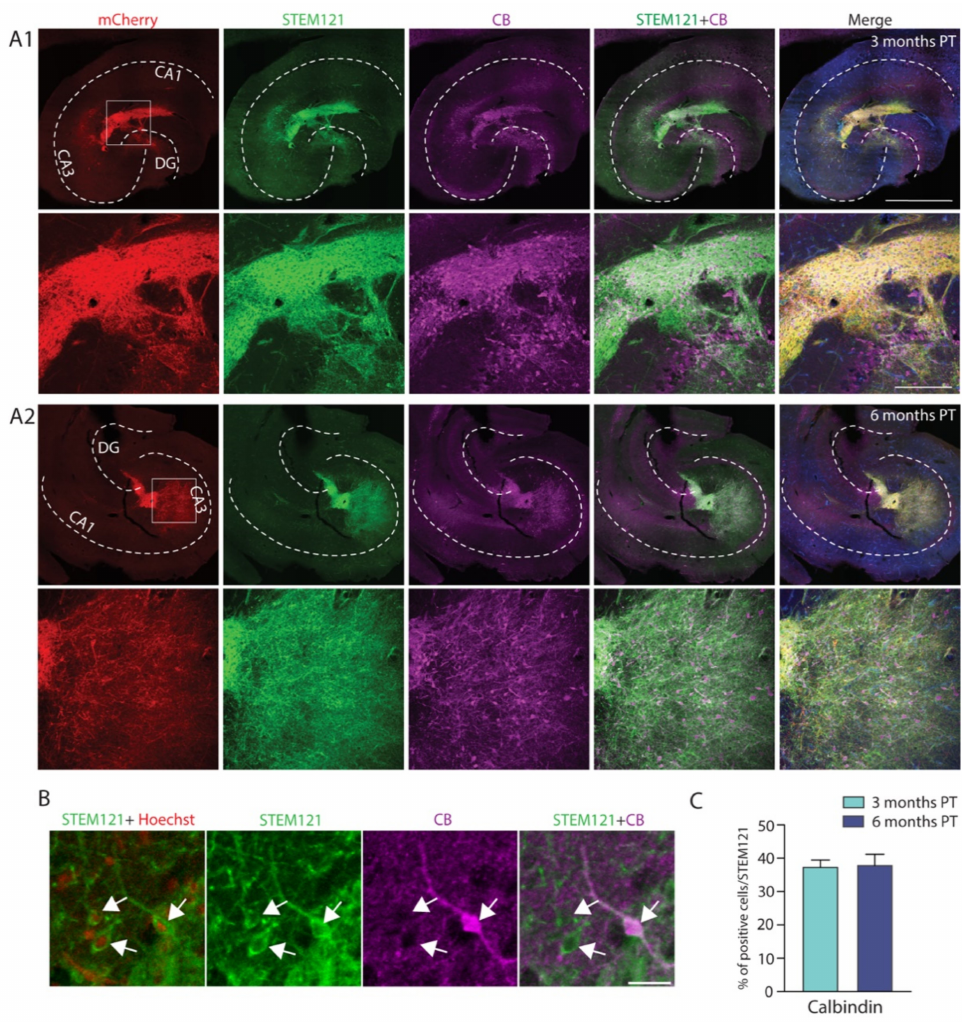
Figure 7. Grafted hdInts express calbindin, a marker of a GABAergic interneuron subpopulation. ( A ) Immunofluorescent images of hippocampal sections with grafted hdInts stained for mCherry (marker for ChR2; red), human cytoplasm (STEM121; green), and calbindin (CB; magenta), merged with Hoechst (blue) in the last right column. CB expression within the graft was observed at both three months PT ( A1 ) and six months PT ( A2 ). ( B ) A merged image of STEM121 and Hoechst was used for counting all STEM121+ cells, while the merged image of STEM121 and CB staining was used for counting STEM121+CB+ double-positive cells. Arrowheads indicate examples of counted cells. ( C ) Quantification of cells stained for STEM121 and CB. The percentage of cells co-expressing both CB and the human cytoplasm marker was similar at both timepoints. Unpaired t -test was used for comparison of means in C. Dashed white line in ( A1 , A2 ) represents the anatomical structure of the hippocampus. Scale bars: 1 mm (( A1 , A2 ) upper row), 200 µ m (( A1 , A2 ) lower row), and 20 µ m ( B